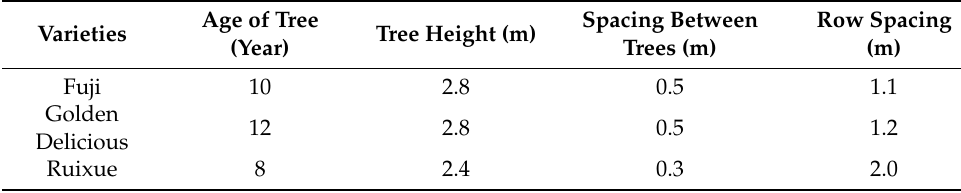
Figure 1. General overview of the study area. ( a ) Geographical location and distribution of the sampling points of the experimental area; ( b ) a schematic diagram of the distribution of the sampling points. Table 1. Planting parameters for three varieties of apple